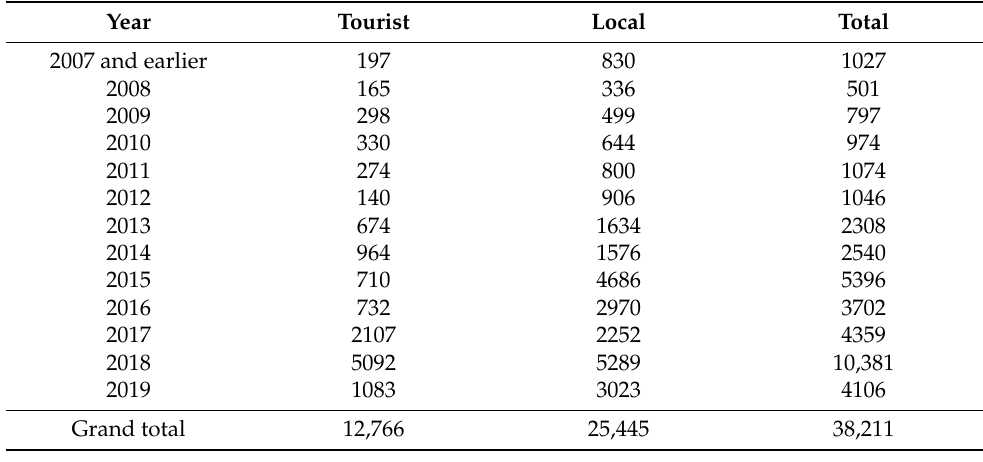
Table A2. Distribution of photographs per year.